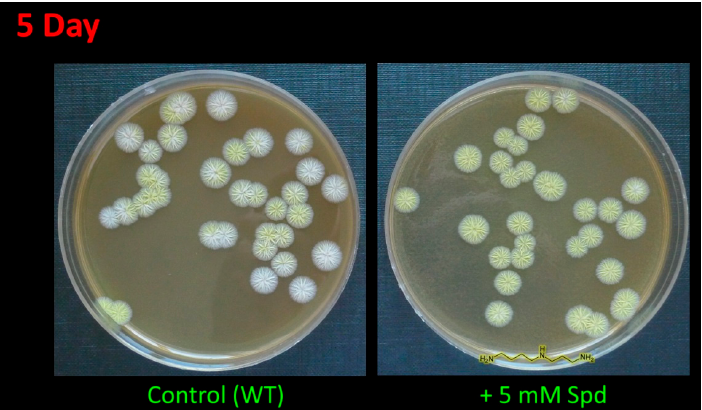
Figure 2. Effect of spermidine (SPD) on pigmentation of A. chrysogenum wild type (WT) strain. After 5 days on agarized complex (CPA) medium with the addition of 5 mM Spd or without addition